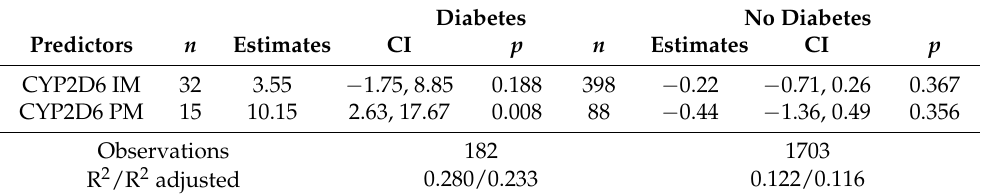
Table 6. Stratified analysis of diabetes status among participants taking venlafaxine. Model adjusted by age, ethnicity, sex, taking inhibitors of CYP2D6, taking antidiabetics and BMI; Normal metabolizers of CYP2D6: diabetes =